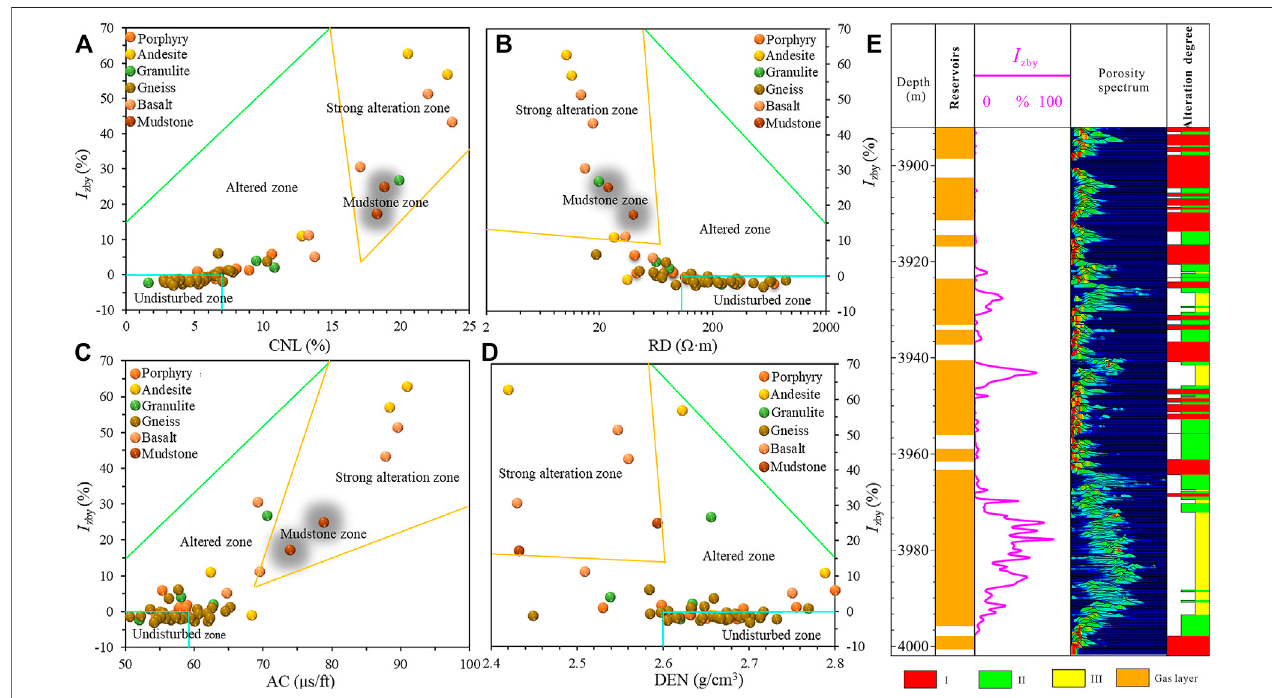
FIGURE5| Qualitativeevaluationofthealterationdegree. (A) I zby andCNL; (B) I zby andRD; (C) I zby andAC; (D) I zby andDEN. (E) Divisionofalteredstratabasedon the I zby peak. The mudstone zone is a range of mudstone characteristic values.